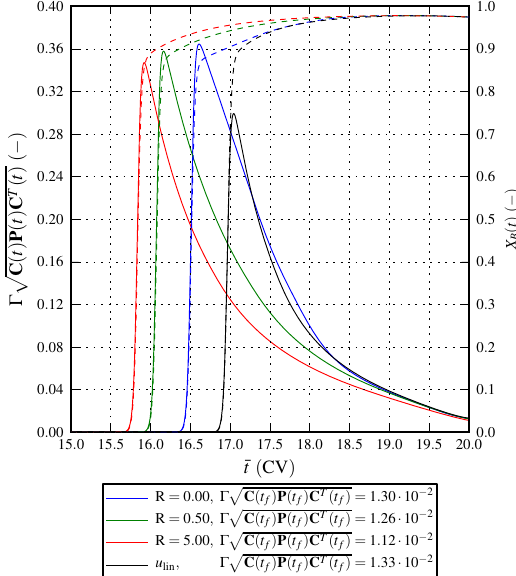
Figure 7. Target component purity, X B ( t ) , (dashed lines) and associated back-off term, Γ C ( t ) P ( t ) C T ( t ) , (solid lines) as a function of time for the nominal elution trajectories depicted in Figure (cid:112)